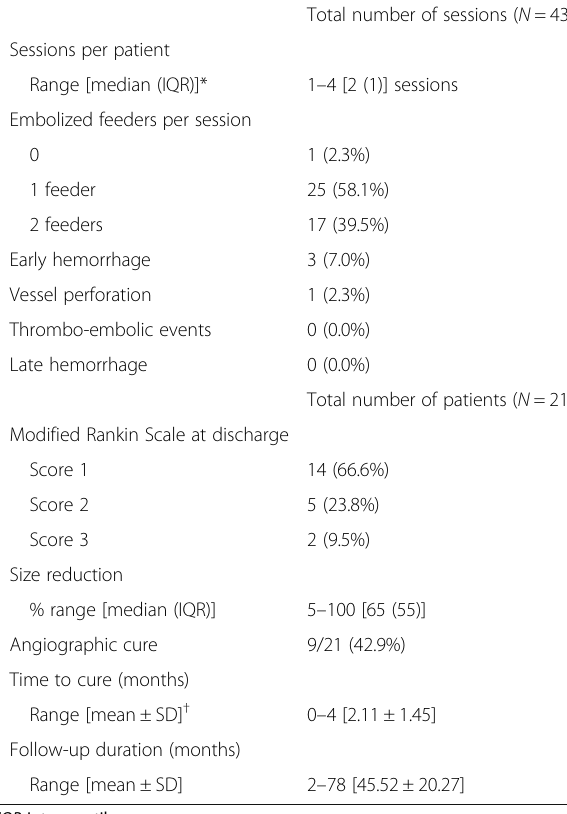
Table 3 Operative data and outcome